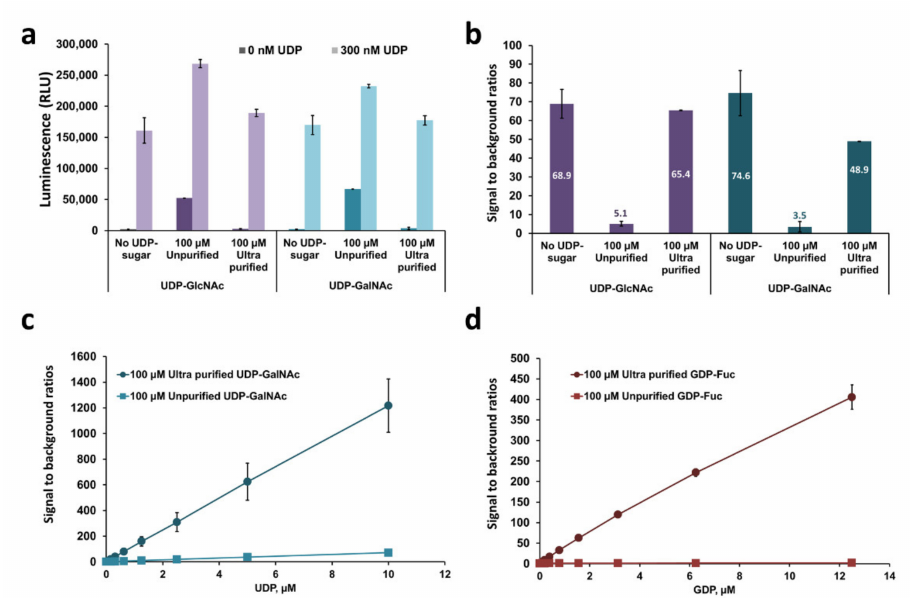
Figure 3. Effect of the sugar substrates purity on the Glo assays performance. Luminescent signal ( a ) and sensitivity ( b ) of the UDP-Glo in the absence or presence of unpurified and ultra-pure sugar substrates. ( c , d ) Standard curves of UDP and GDP detected with of UDP-Glo and GDP-Glo, respectively, in the presence of unpurified or ultra-purified sugar